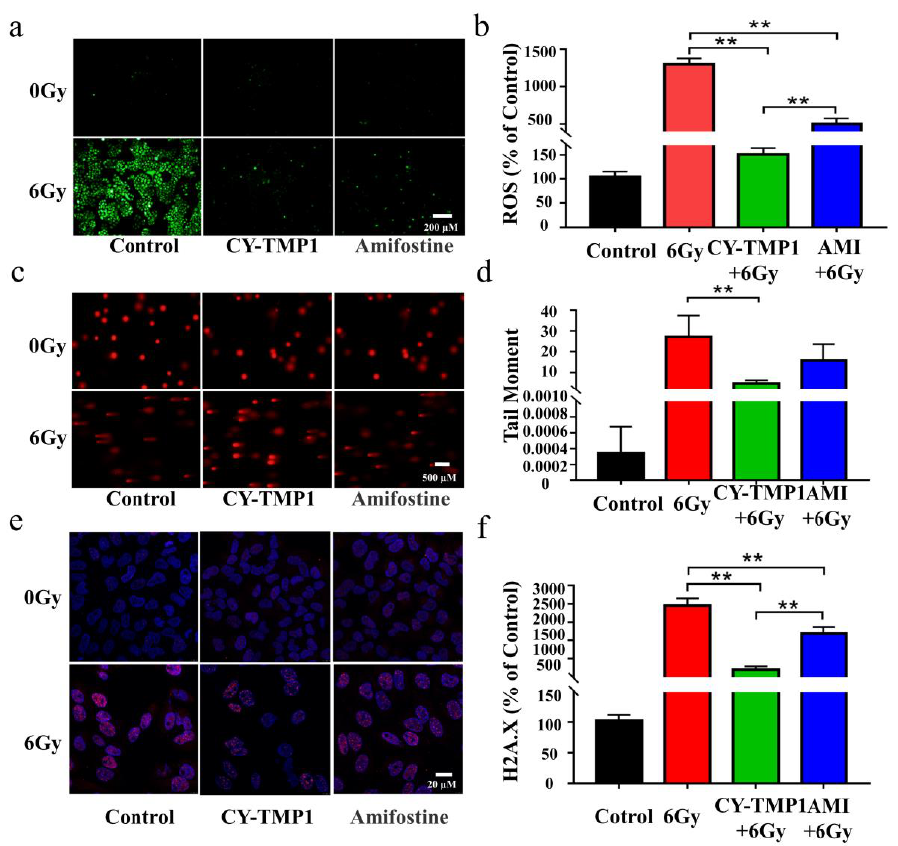
Figure 2. Comparison of radioprotective effect between CY-TMP 1 and Amifostine (Ami) on L-02 cells. ( a ) The total intracellular ROS induced by X-ray radiation were probed with Reactive Oxygen Species Assay Kit and ( b ) quantitatively measured 24 h after radiation. ( c ) Fluorescence imaging and ( d ) quantitative analysis of comet tail as an index of DNA damage. ( e ) Fluorescence imaging and ( f ) quantitative analysis of γ -H2A.X based on immunofluorescent staining. Compared to the 6 Gy radiation group, CY-TMP1 significantly decreases radiation-induced ROS level and DNA damage ( n = 6, mean ± SD, ** p < 0.01). Compared to the Ami-treated group, CY-TMP1 also exhibits significantly higher efficiency in ROS-scavenging ability and reducing the ratio of DNA double chain breaks induced by ionizing radiation ( n = 6, mean ± SD, ** p < 0.01). The potential radioprotection of CY-TMP1 was also investigated by the comet assay and γ -H2A.X immunofluorescent staining, which are typical techniques for evaluation of DNA damage after cells are exposed to ionizing radiation. The tail length of comet as an index of DNA damage was measured with the Comet Assay Software Project (CASP). Both fluorescence imaging and quantitative analysis of comet tail demonstrated that CY- TMP1 effectively alleviated the DNA damage from 6 Gy irradiation (Figure 2c,d). The tail length in the CY-TMP1 group was measured obviously shorter than that in the Amifostine group. Similarly, γ -H2A.X immunofluorescent staining of CY-TMP1-treated L-02 cells displayed significantly lower expression of γ -H2A.X protein (pink spots) than cells in the 6 Gy irradiation control group and the Amifostine-treated group (Figure 2e,f). Based on the above results, CY-TMP1 showed efficient ROS-scavenging ability and radioprotective effect, which was significantly higher than Amifostine.